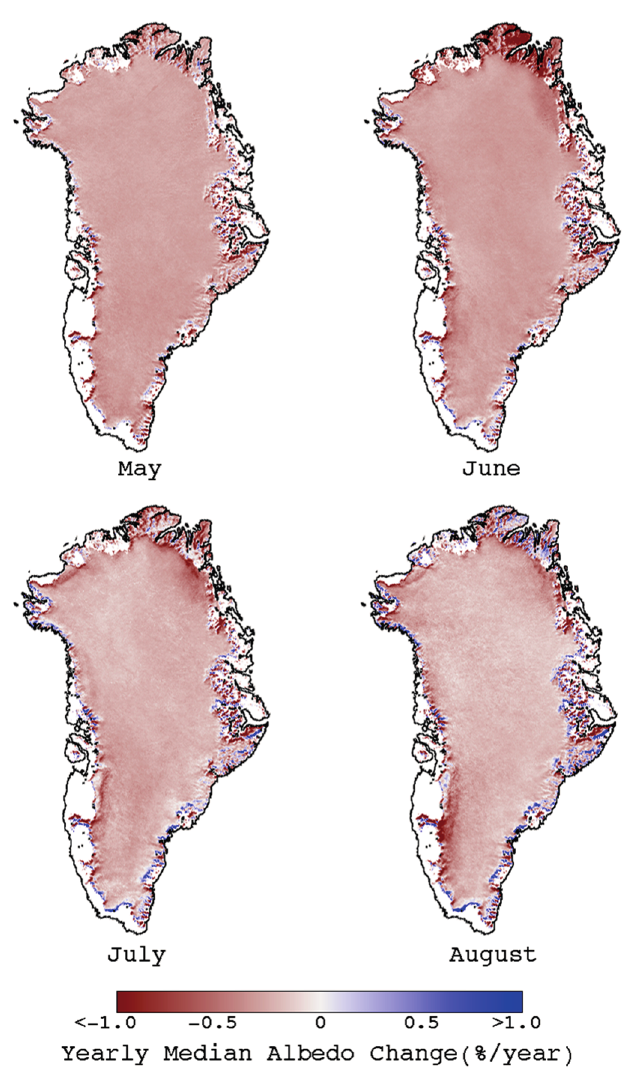
Figure 5. An example of trend analysis using the data rods concept. Shown are the average yearly changes in albedo from 1981 to 2005 using data from the AVHRR Polar Pathfinder dataset. A data rod was created at each grid cell; filtering and statistical methods within the data rod objects then binned the data by month ( May , June , July , or August ), eliminated cloudy data, produced a median albedo for each month-year combination, and performed linear regressions across all years. The resulting trends at each grid cell were then used to generate the Greenland images below. Note that the 1981–2005 trend is predominantly negative for most interior locations. The magnitude of this trend was unexpected because, in general, significant interior albedo changes have been observed only after 2005